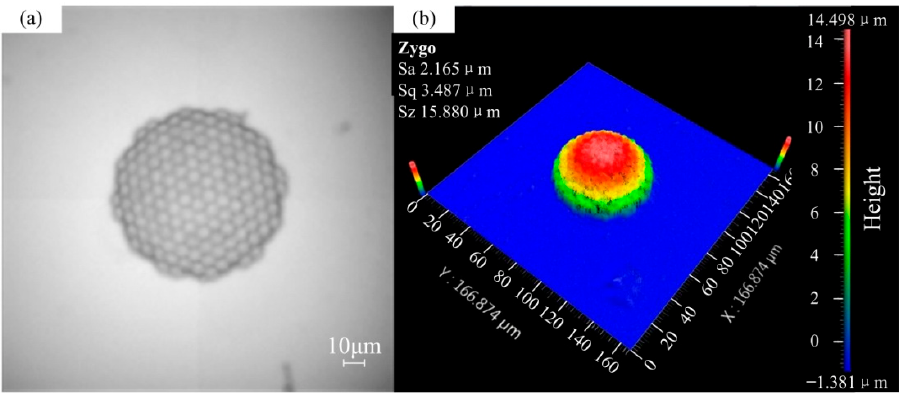
Figure 4. The test result of the designed compound eye: ( a ) Optical detection of the artificial compound eye; ( b ) Size measurement of the artificial compound eye.